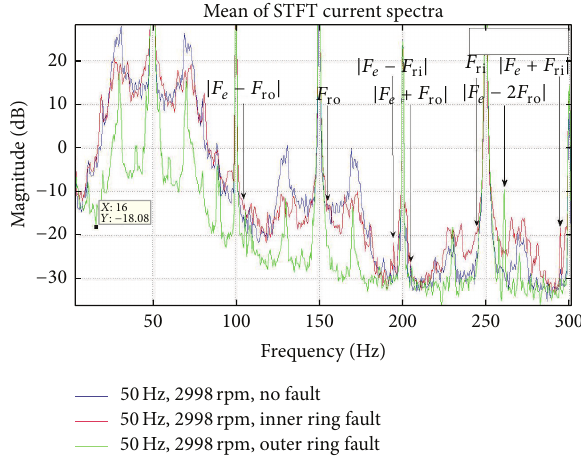
Figure 12: Nominal, inner defect, and outer defect spectra (0– 300 Hz) of 50 Hz motor input, free load condition, and current